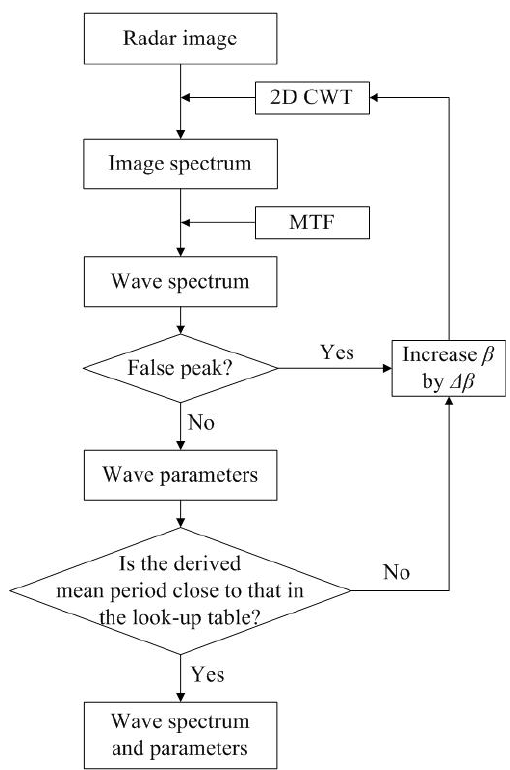
Figure 9. Flowchart of the self-adaptive 2D continuous wavelet transform (2D-CWT)-based